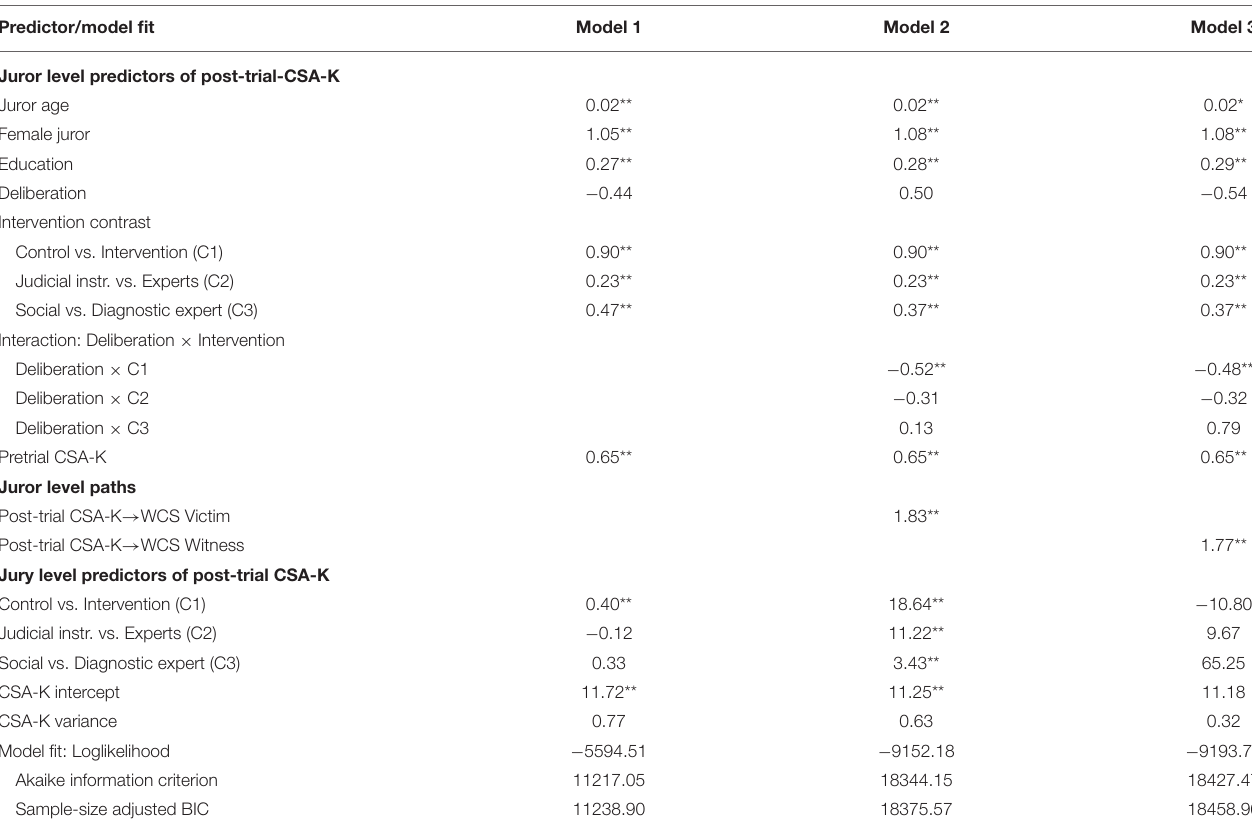
TABLE 5 | Multilevel SEM analysis predicting CSA knowledge and witness credibility: unstandardized coefficients